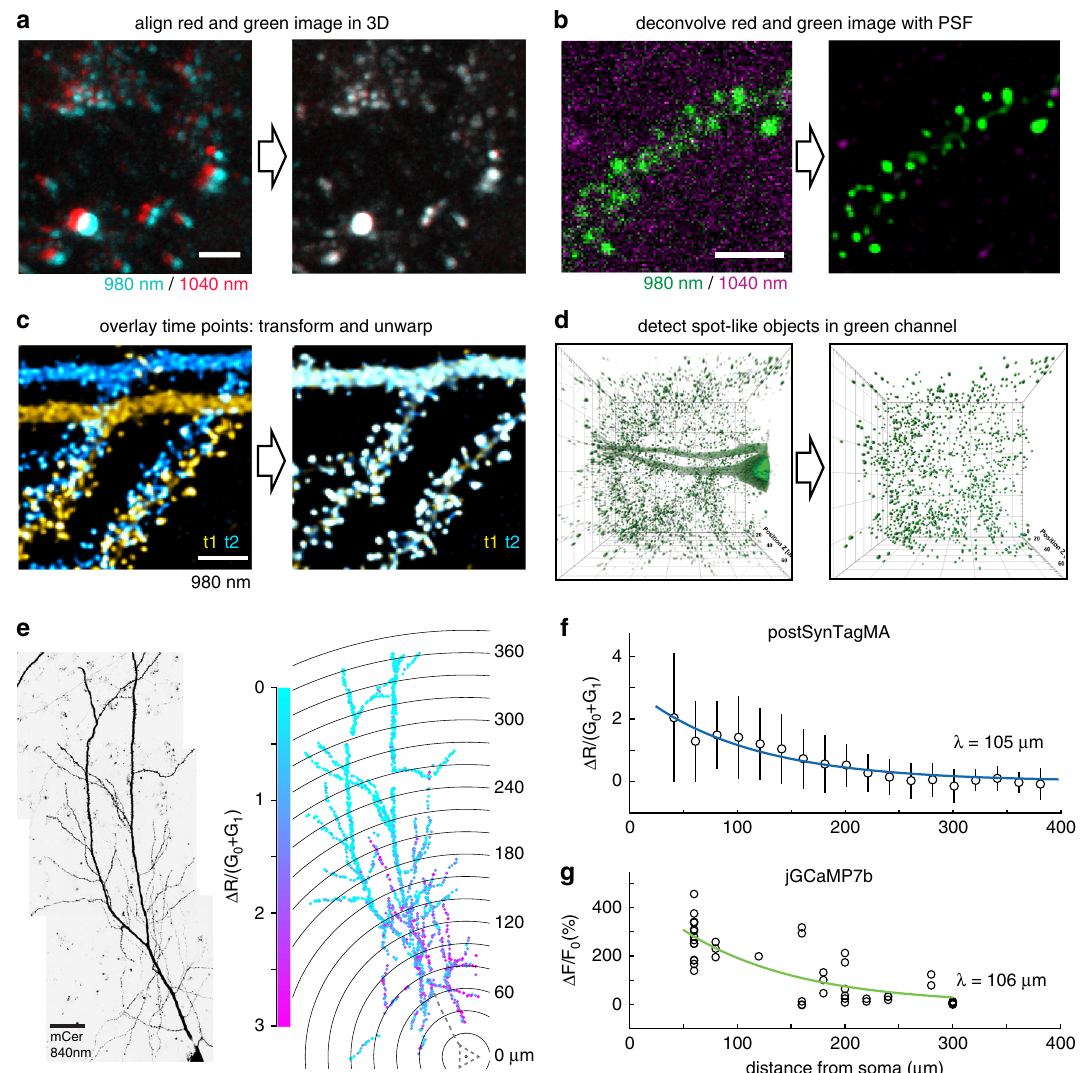
Fig. 5 Work fl ow for automated detection and analysis of SynTagMA photoconversion. a Green and red fl uorescence is collected in alternate frames, switching between two Ti/Sapph lasers (980nm/1040nm). Images are registered in 3D to correct for chromatic aberration and laser alignment. b Median fi ltering and deconvolution is then applied to all images (both green and red channels). c To superimpose multiple time points in 3D, translation, rotation and unwarping are applied. d Synapses (ROIs) are detected as spherical objects, i.e., ‘ spots ’ from which fl uorescence values are extracted and analyzed. e Maximum intensity projection of a CA1 pyramidal cell expressing cytosolic mCerulean (inverted gray scale) and postSynTagMA. The cell was stimulated with 50 bAPs at 100Hz and illuminated with 395nm (as in Fig. 4). For each identi fi ed synapse, Δ R/(G 0 + G 1 ) was analyzed, color-coded, and plotted at its original location. Distance from soma is indicated as concentric rings. f Photoconversion decreased exponentially from the soma with a distance constant of λ = 105 µ m (median±interquartile range, n = 1860 synapses, 1 cell, R 2 = 0.91). This experiment was reproduced in 4 neurons. g Spine calcium transient amplitudes during 50 bAP trains (jGCaMP7b) decreased exponentially with distance from the soma with λ = 106 µ m ( n = 55 synapses, 5 neurons, R 2 = 0.66). Scale bar: 4 µ m ( a , b , c ), 30 µ m ( e